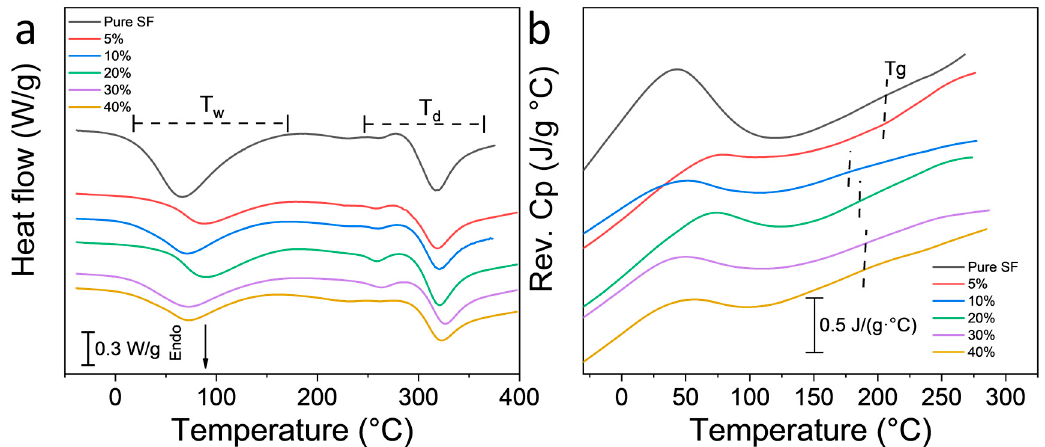
Figure 4. ( a ) Total heat flow curves of electrospun SF and BNSF nanofibers; ( b ) the reversing heat capacity curves of BNSF nanofibers. The scans were at a rate of 2 °C/min and temperature was modulated every 60 s at an amplitude of 0.318 °C.